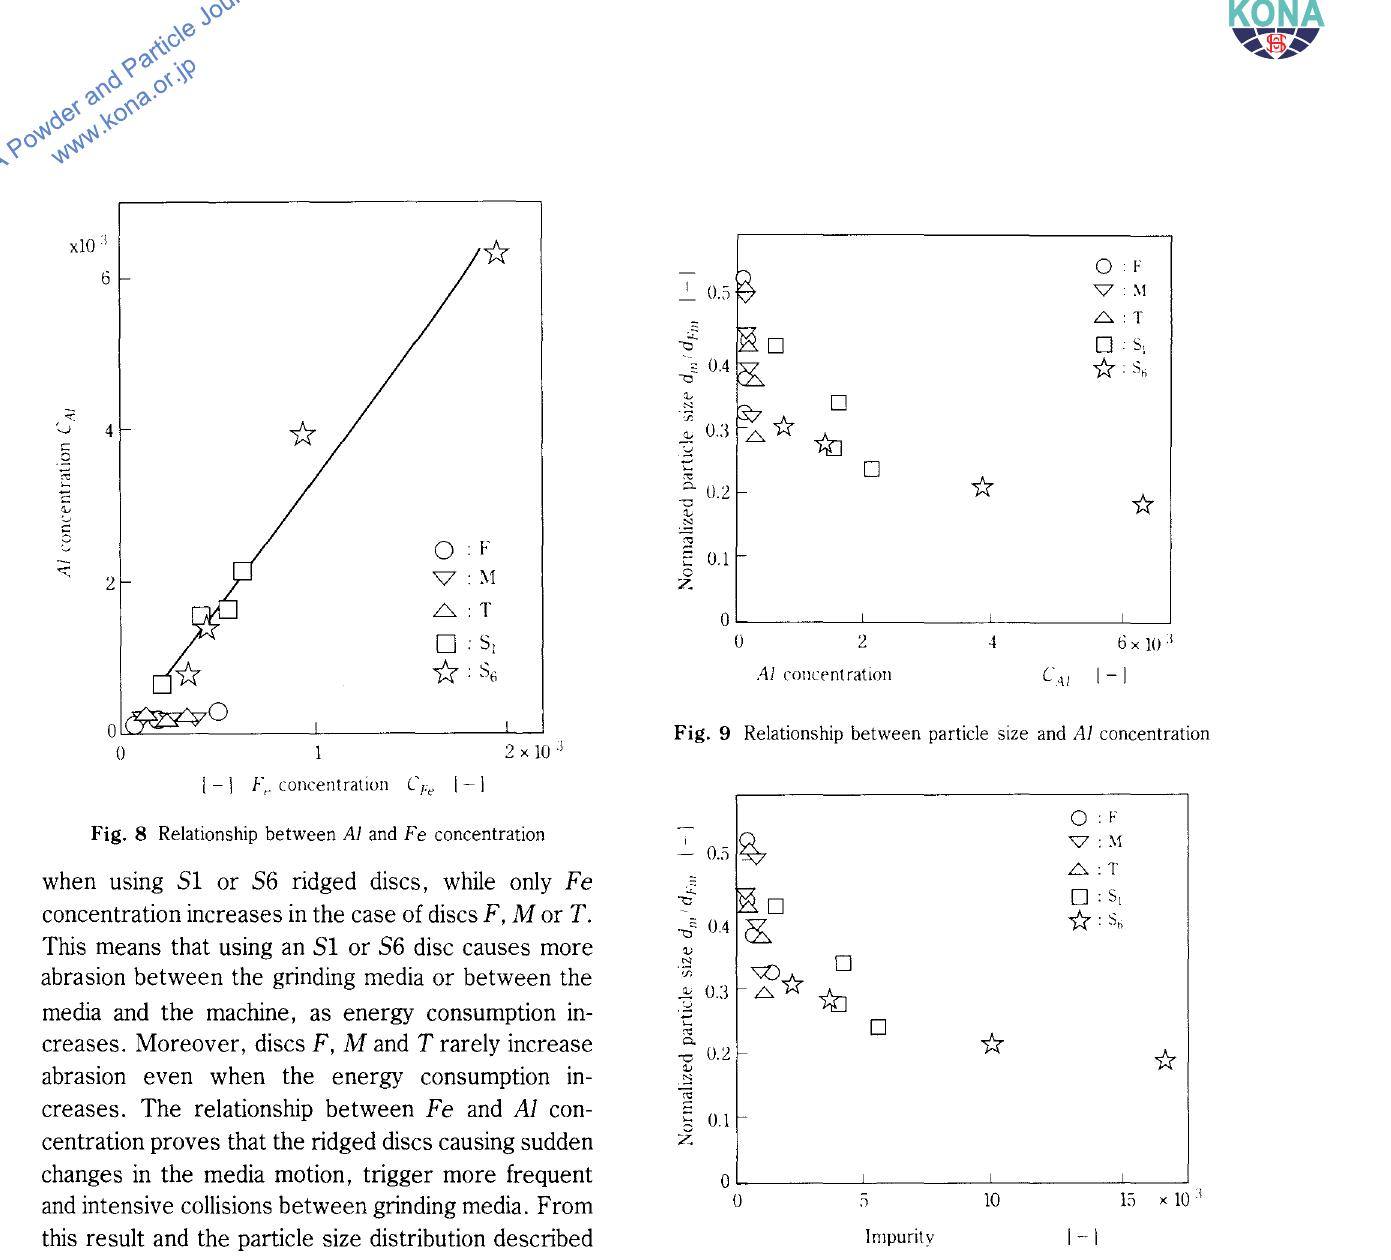
Fig. 9 Relationship between particle size and Al concentration